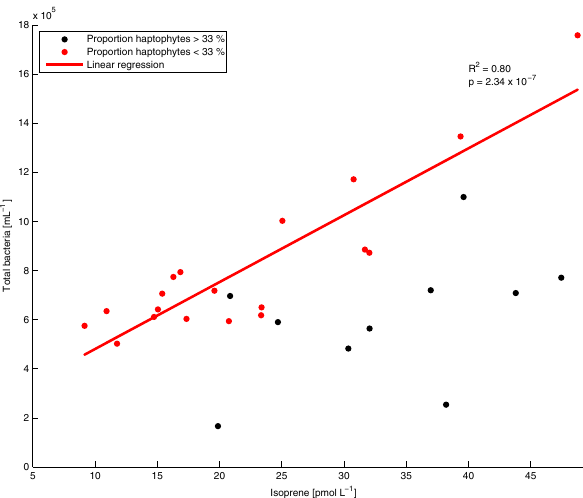
Figure 8. Different mean loss rate constants ( ± SD) during SPACES, OASIS; and ASTRA-OMZ. Blue points: calculated loss rate ( k consumption ); blue dotted line: k BIOL from Booge et al. (2016); blue dashed line: k BIOL from Palmer and Shaw (2005); red dashed line: k CHEM ; black points: calculated loss rate constants due to air–sea gas exchange.